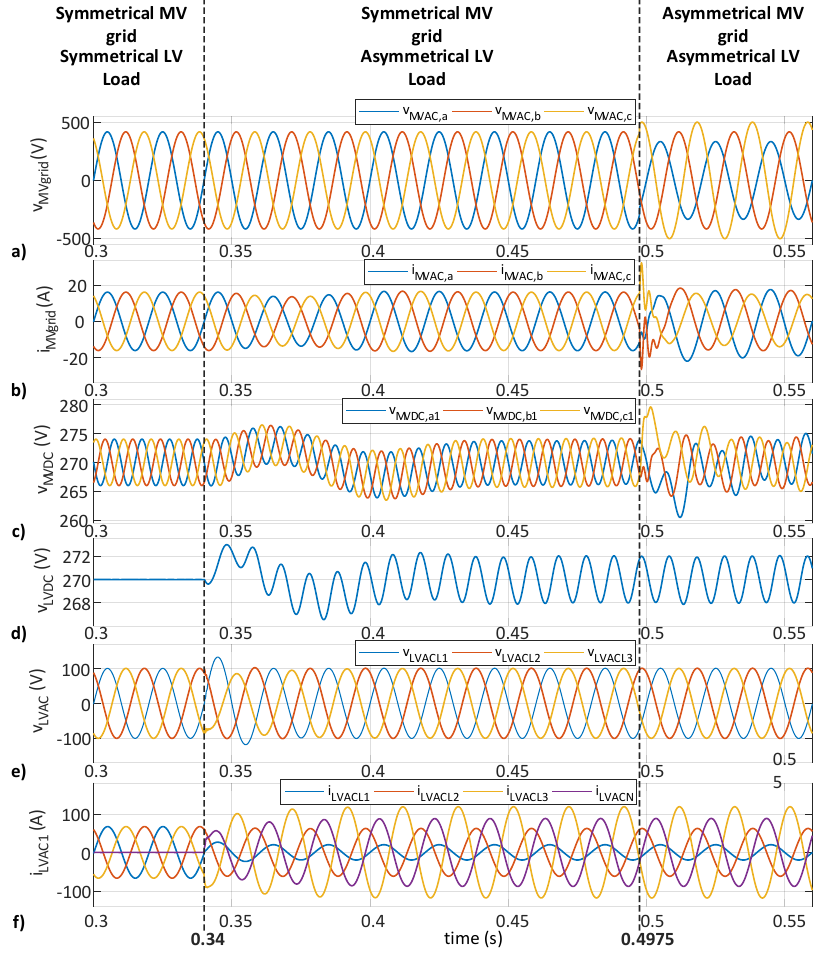
Figure 13. The voltages and currents of the ST—all modules integrated, ( a ) grid voltages on the MV side of ST, ( b ) grid currents, ( c ) DC-link voltages for one module in each phase, ( d ) LV DC-link voltage, ( e ) LV grid (load) voltages, ( f ) load currents.